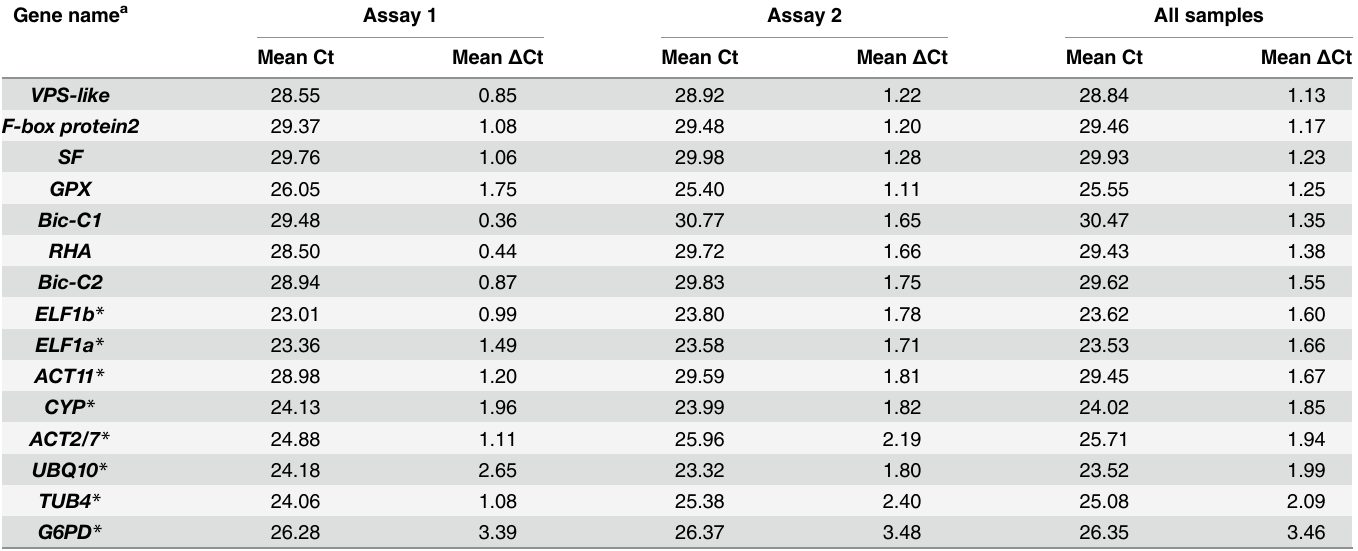
Table 3. Evaluation of reference genes using RT-qPCR